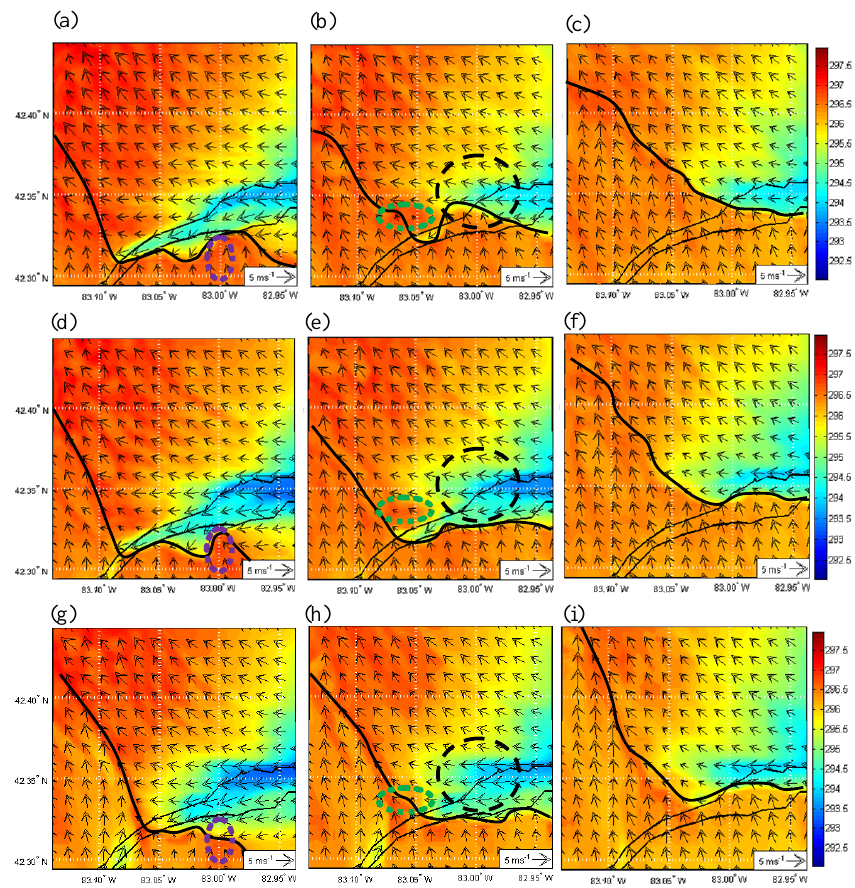
Fig. 13. Temperature (K), at the lowest model layer ( ∼ 28ma.g.l.) over the fourth model grid of the domain at 22:10 (a, d, g) , 22:50 (b, e, h) 23:20UTC (c, f, i) 23 June 2007 for case 10s (a–c) , case 20s (d–f) and case 60s (g–i) . Horizontal wind speed for each case at this height is shown in vectors scaled by the reference vector at the lower right. The estimated position of the lake breeze front is indicated by the thick black contour. The dashed ovals highlight particular examples of discrepancy in lake breeze front position between cases and are discussed further in the